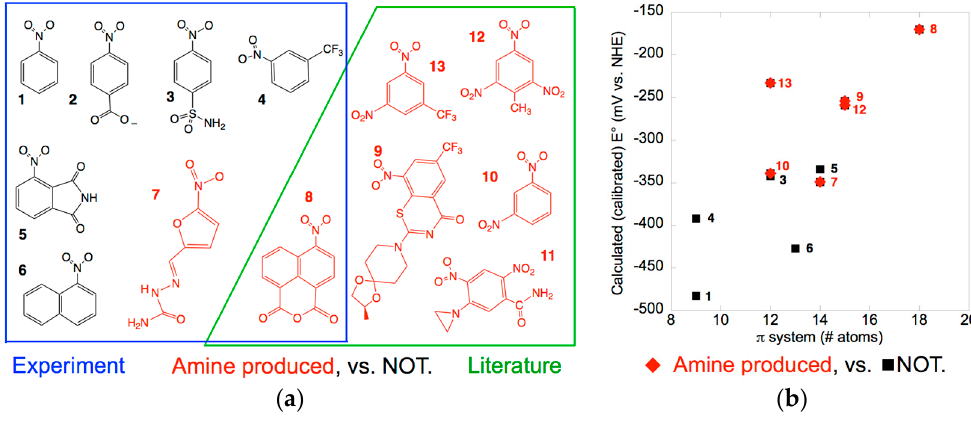
Figure 2. ( a ) Compounds investigated for amine formation by Ms PnbA and St NfsB. Compounds for which amine products were produced ( 7 – 13 ) are in red, those for which amine production was below our detection limit are in black ( 1 – 6 ). Compounds included based on literature reports are in a green box, compounds studied in this work are in a blue box. This figure provides the structures of BTZ043, 9 and CB1954, 11 ; ( b ) Compound names and ChemSpider ID codes are given in Materials and Methods and Supplemental material.